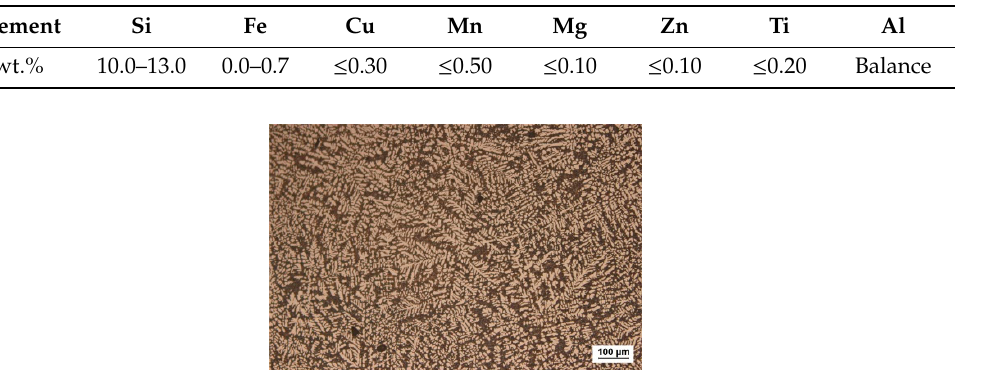
Figure 1. Microstructure of 55 vol.% SiC p /ZL102 composites. Table 1. Chemical composition of ZL102 (in wt.%).